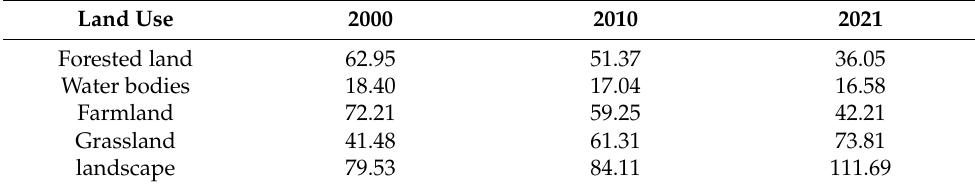
Table 6. LSI values of green spaces in central Fuzhou during the period 2000, 2010, 2021.